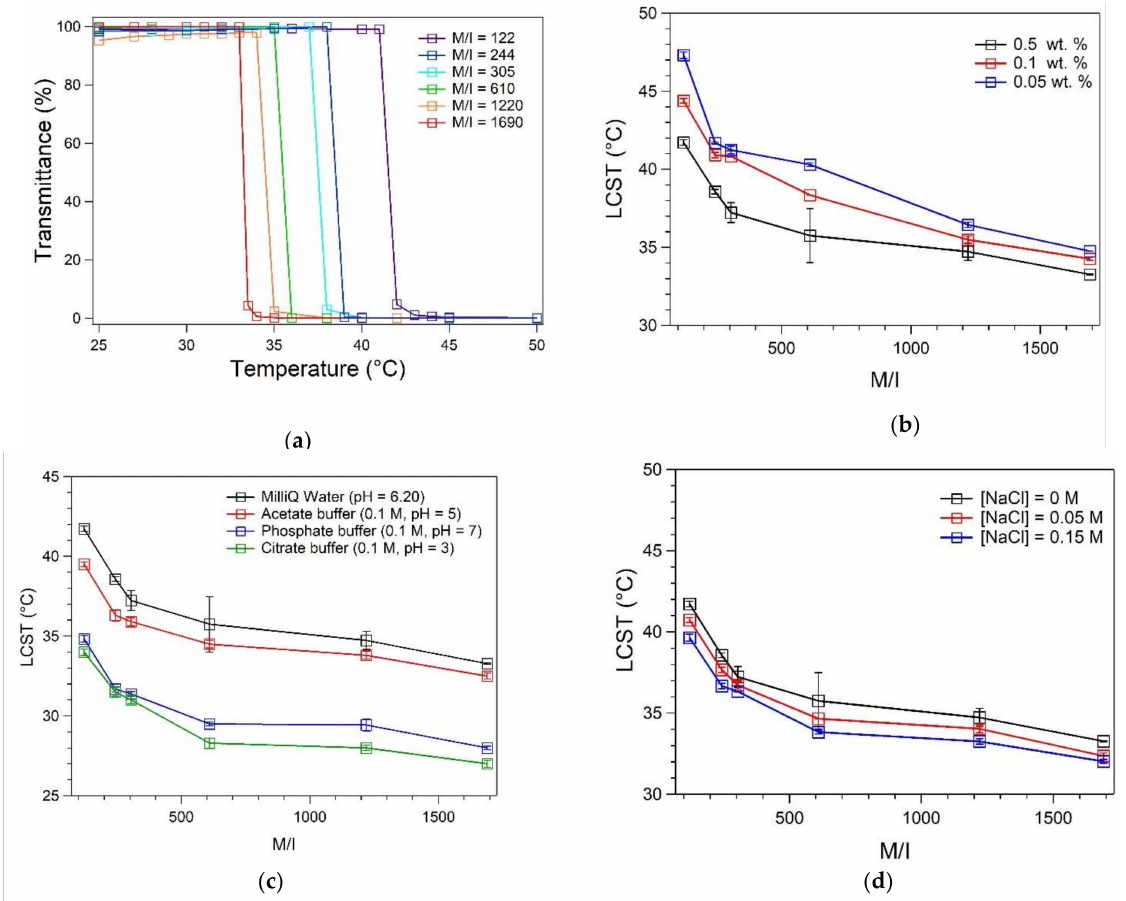
Figure 4. ( a ) Miscibility curves (transmittance vs. temperature) of PNVCL-COOH polymers at the concentration of 0.5 wt.% in milliQ water (pH = 6.20). ( b ) Variation of LCST reported as a function of the PNVCL-COOH concentration in milliQ water (pH = 6.20). ( c ) Variation of LCST of 0.5 wt.% PNVCL-COOH solutions associated to different type of buffers. ( d ) Variation